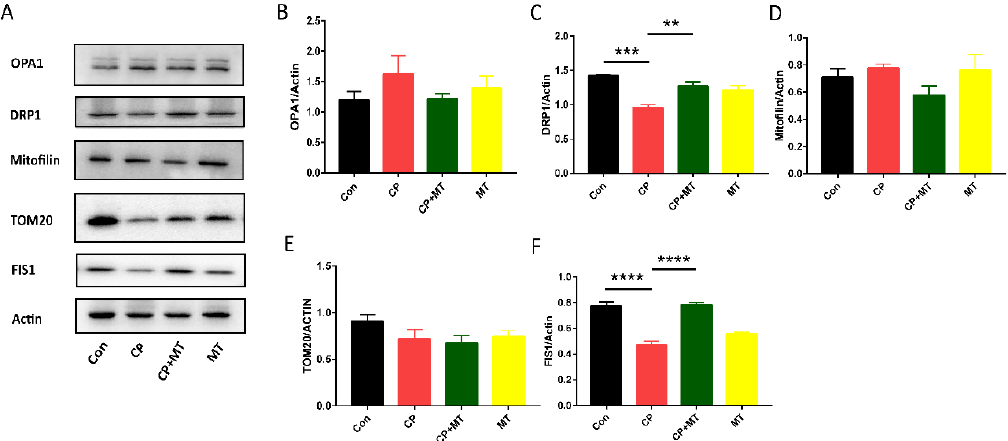
Figure 4. MT protected the ovary from CP-induced mitochondrial damage. ( A ) Western blot analysis for TOM20, Mitofilin, OPA1, FIS1, and DRP1 expression in the Con, CP, CP + MT, and MT groups ( n = 3). Actin was used as an internal control to measure the quality of protein. ( B ) Relative intensity of OPA1 was assessed by densitometry. ( C ) Relative intensity of DRP1 and actin were assessed by densitometry. ** significant difference ( p < 0.01).*** significant difference ( p < 0.001). ( D ) Relative intensity of Mitofilin was assessed by densitometry. ( E ) Relative intensity of TOM20 was assessed by densitometry. ( F ) Relative intensity of FIS1 was assessed by densitometry. **** significant difference ( p < 0.0001).